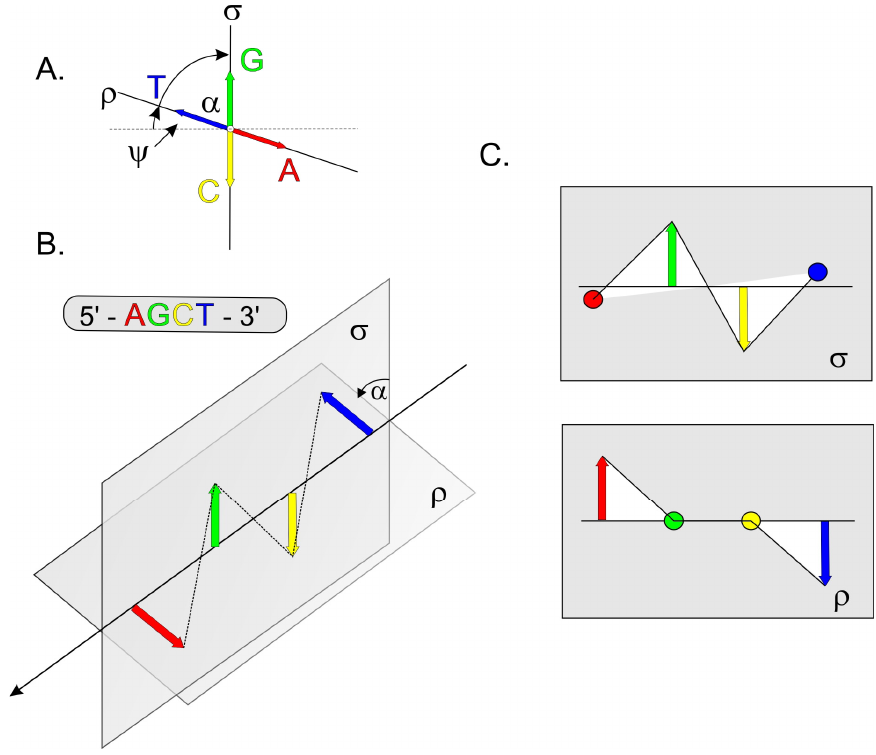
Figure 1. Schematic representation of the semi-orthogonal system (18). ( A ) Orientation of the oligonucleotide in the system; ψ is the angle of inclination from orthogonality, α is the angle of the projection planes of the nucleotides σ and ρ . ( B ) Example of 5 ′ -AGCT-3 ′ sequence projection in a semi-orthogonal system. ( C ) Projection of this sequence onto the planes σ and r.